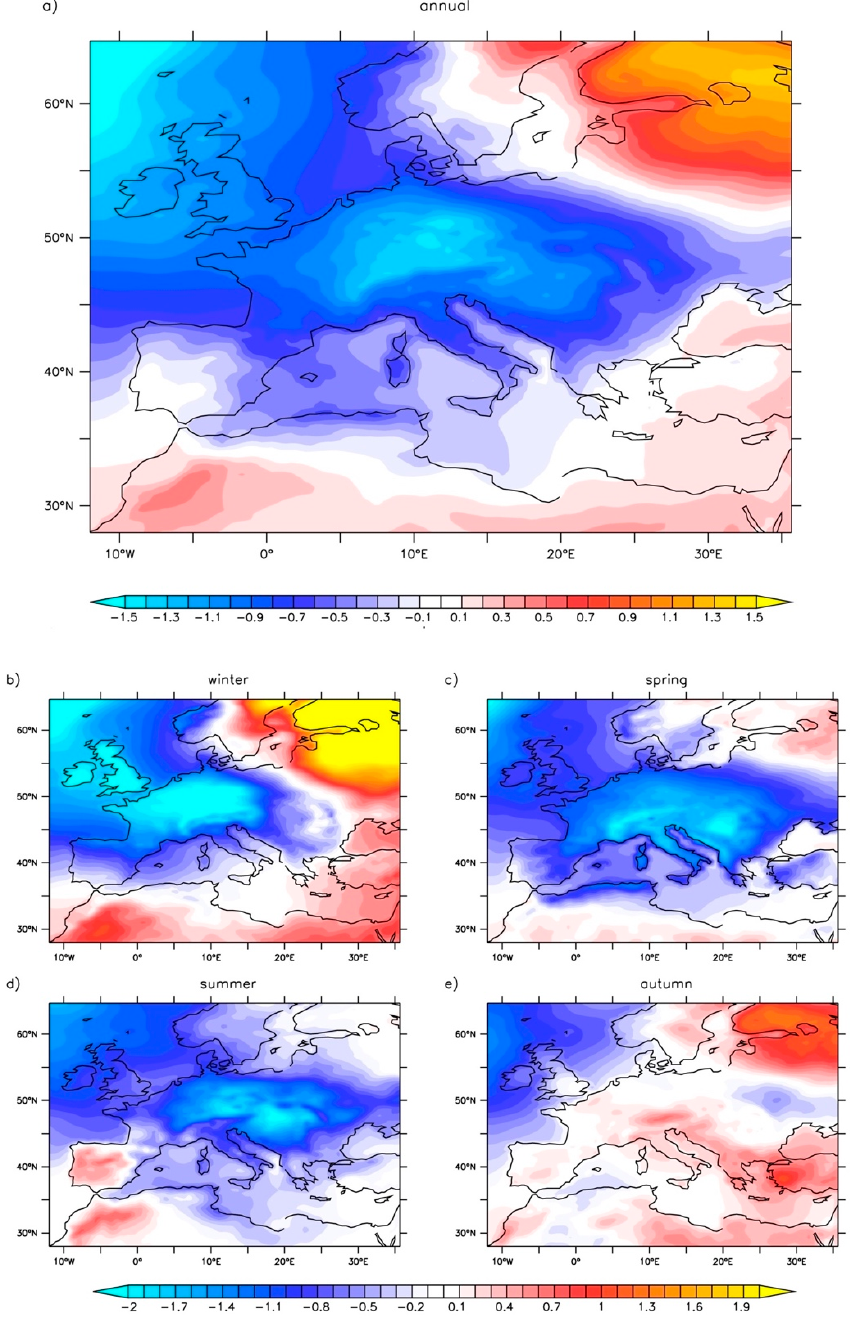
Figure 3. Pattern of the mean air temperature anomaly (in ° C) between the decade 2069–2078 and the Annual, ( b ) winter, ( c ) spring, ( d ) summer, and ( e ) decade 2059–2068 as simulated by the downscaled CSIRO-Mk3-6-0 model for different periods: ( a ) Annual, ( b ) winter, ( c ) spring, ( d ) summer, and ( e ) autumn.